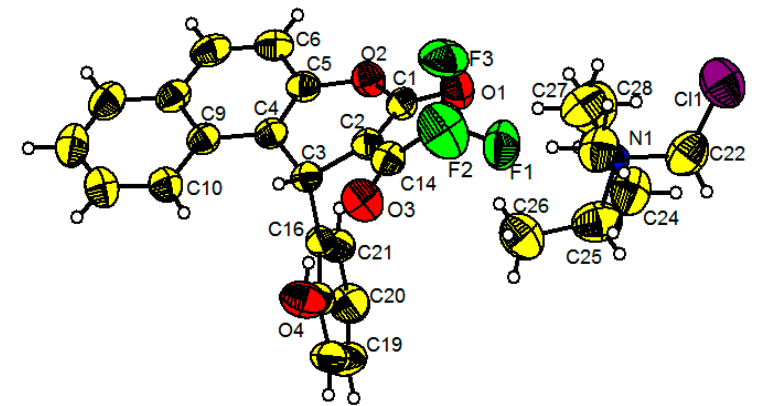
Figure 2. The ammonium salt 3a 1 of compound 3a (CCDC 1900315). Note: yellow, carbon; white, hydrogen; red, oxygen; green, fluorine; blue, nitrogen; purple, chlorine.